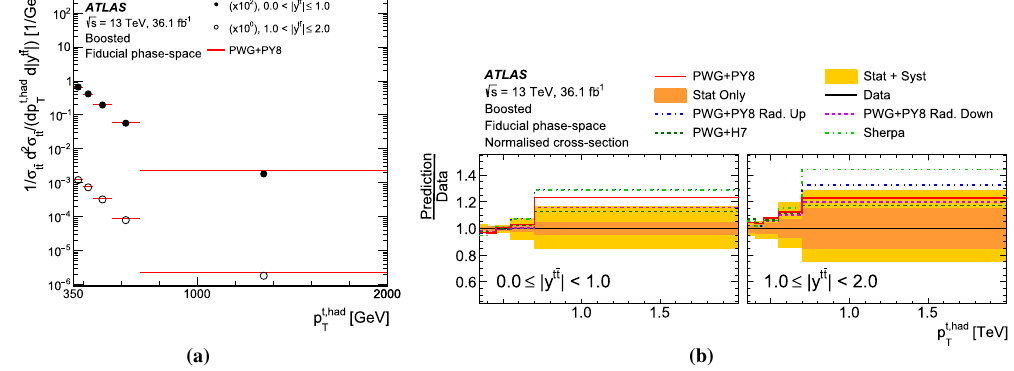
Fig. 44 a Particle-levelnormaliseddifferentialcross-sectionasafunc- tion of p t , had T